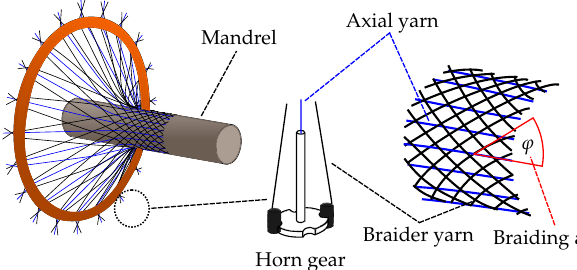
Figure 1. Schematic sketch of preforming technology braiding.